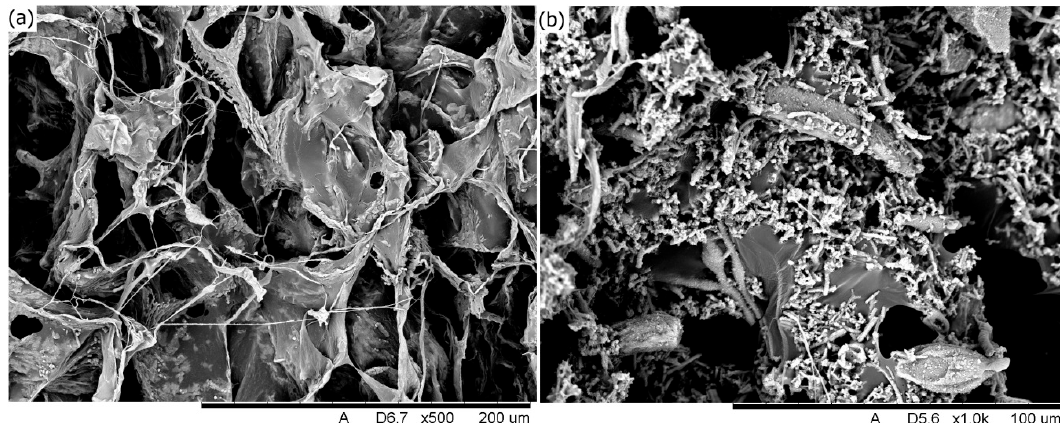
Figure 6. SEM images of the ( a ) COL scaffold and ( b ) COL-HANF scaffold.